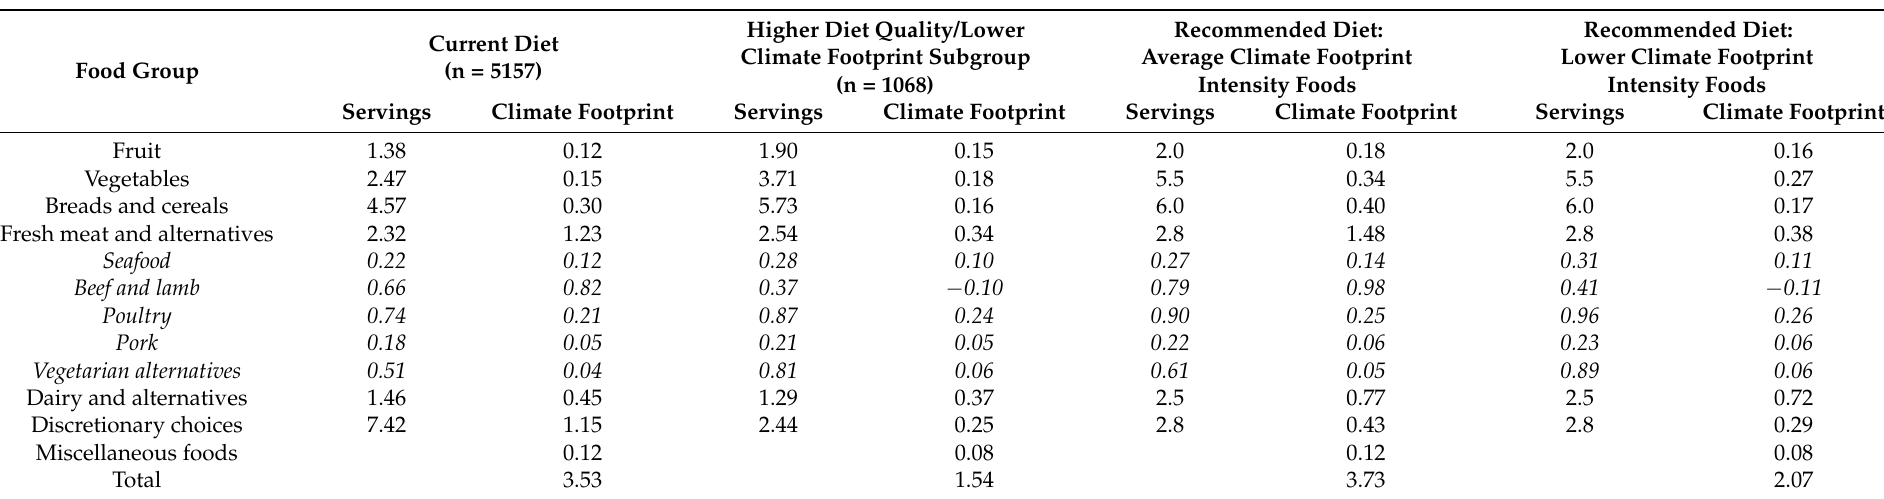
Table 2. Food intake (servings person − 1 ) and climate footprint (kg CO 2 -e person − 1 ) for current and recommended Australian adult (19–50 years old) daily diets 1 .